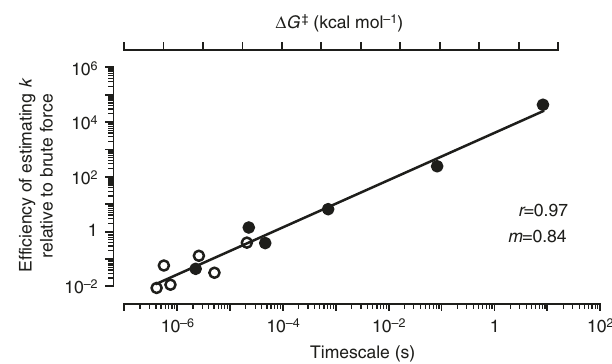
Fig. 5 Ef fi ciency of the computational strategy for simulating long-timescale processes. The ef fi ciencies of WE simulations relative to brute-force simulations in computing rate constants for switching processes scale linearly with the timescale of the process, i.e., exponentially with the height of the corresponding free-energy barrier Δ G ‡ (see Supplementary Methods). Solid circles (WT constructs) represent the mean of n = 10 independent WE simulations, and open circles (mutant constructs) represent the mean of n = 3 independent WE